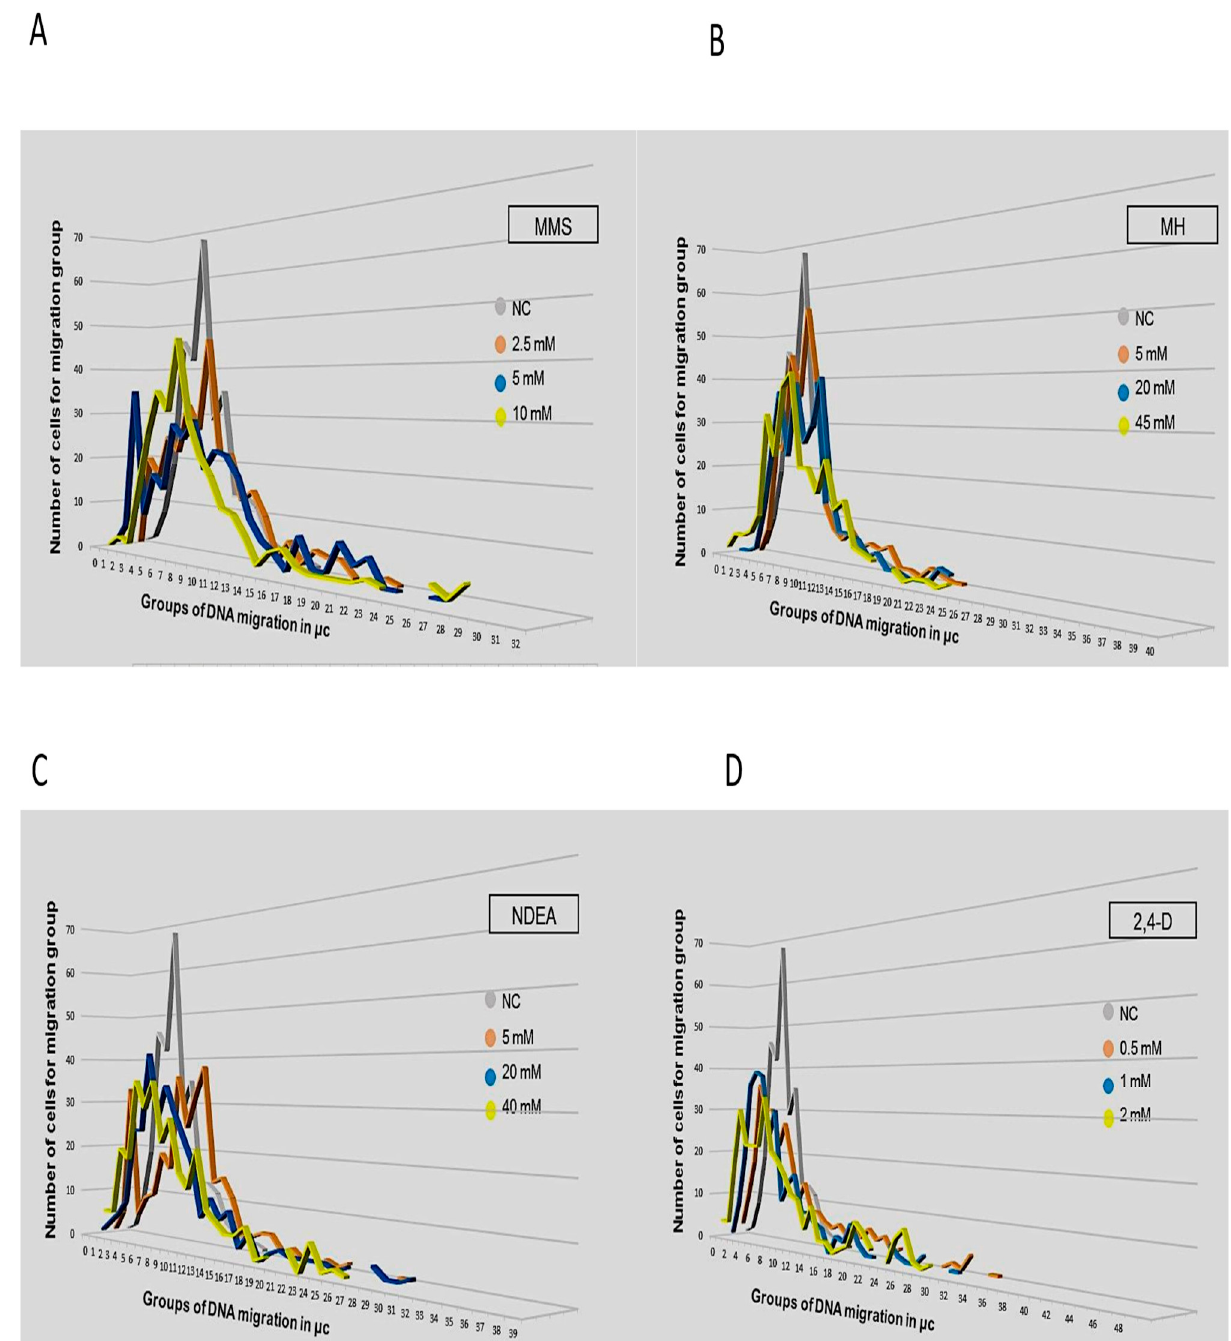
Figure 1. Migration groups and number of comets observed per group after exposure to three different concentrations of MMS ( A ), MH ( B ), NDEA ( C ), and 2,4-D ( D ). Each peak corresponds to a migration group with a different number of comets.